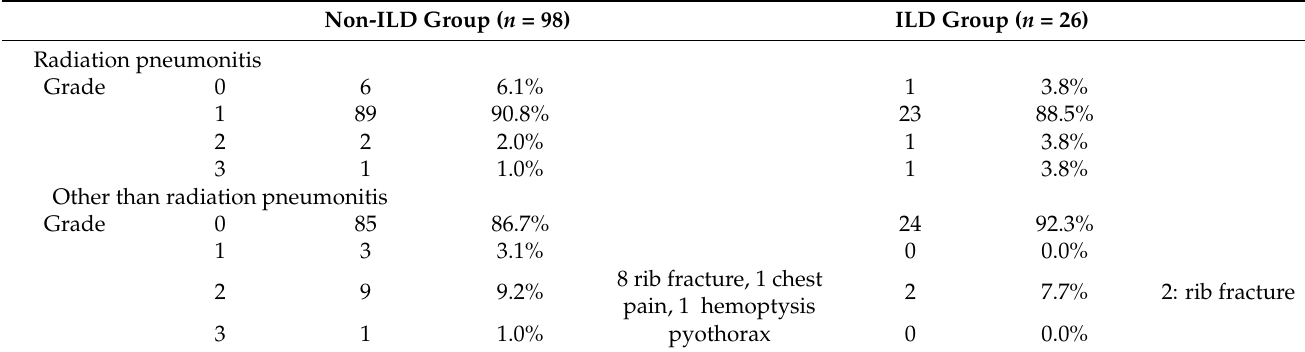
Table 3. Adverse events (CTCAE ver.4.0).